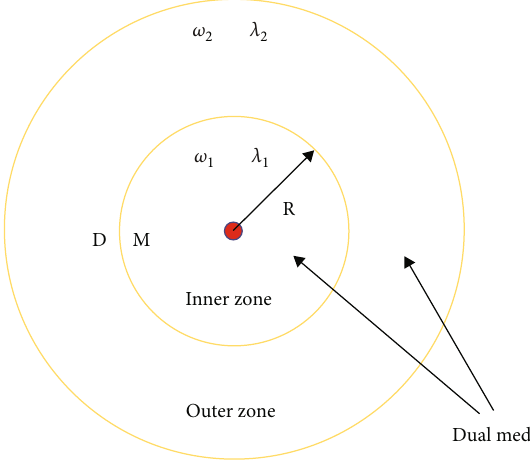
Figure 2: Dual-media composite reservoir model (cite from Feng ’ s work